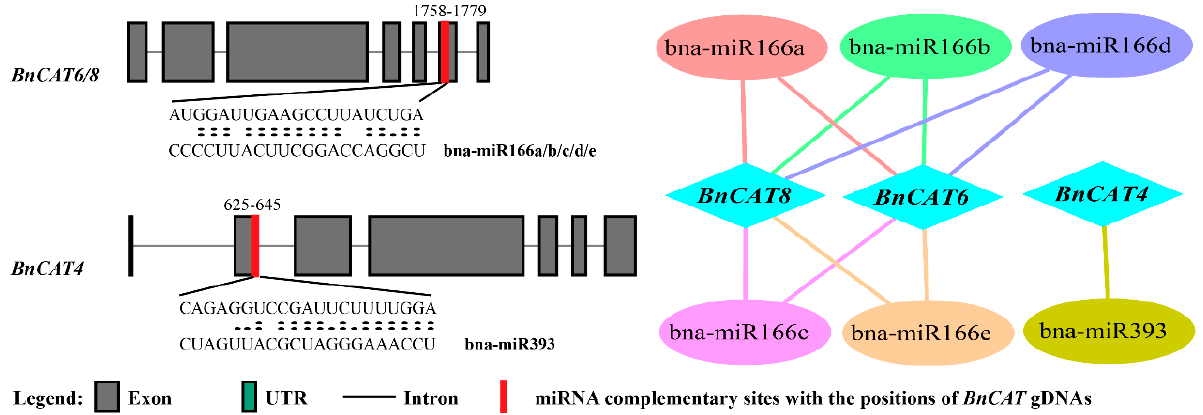
Figure 6. A network illustration of the regulatory associations among the presumed miRNAs and selective BnCAT genes.